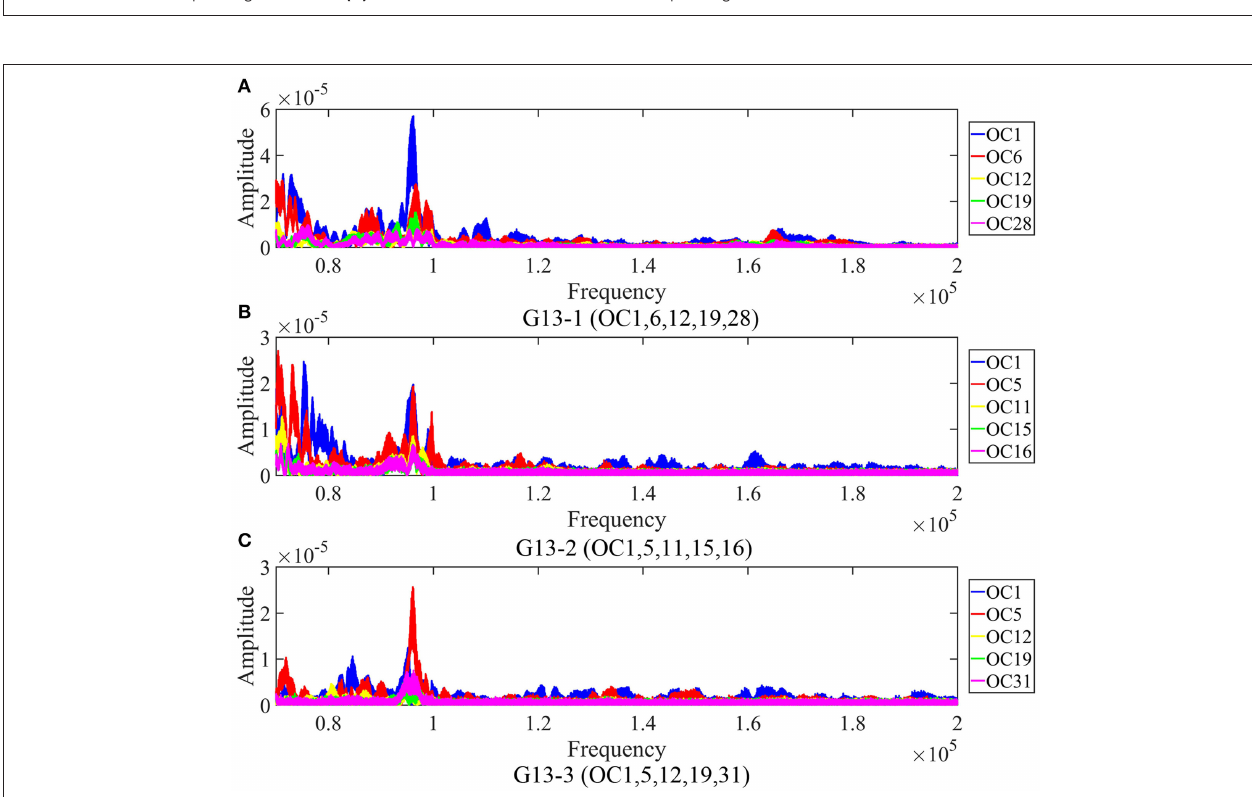
FIGURE 6 | Frequency-domain signal of G13 after testing under different operating conditions. (A) Frequency domain of G13-1 under different operating conditions. (B) Frequency domain of G13-2 under different operating conditions. (C) Frequency domain of G13-3 under different operating conditions.